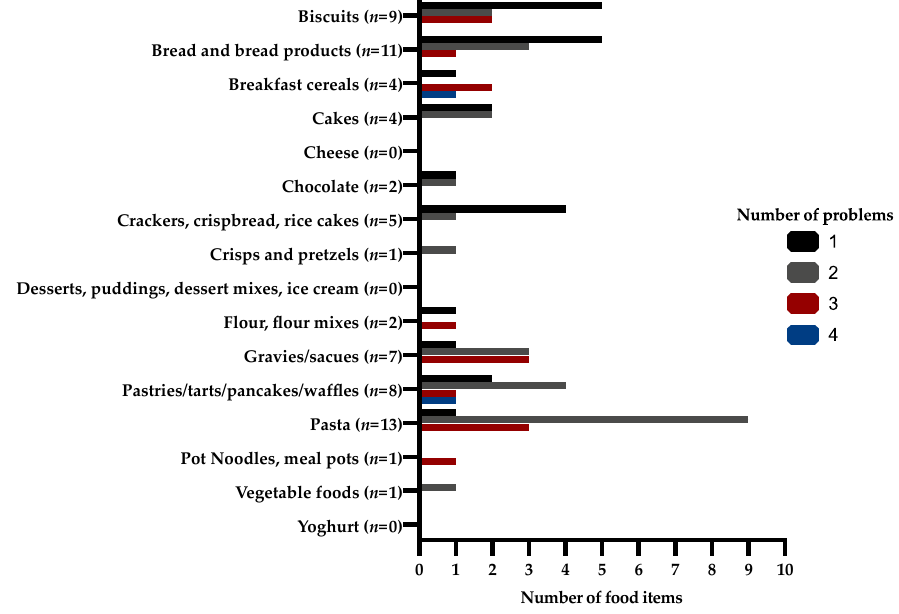
Figure 1. Frequency of misleading, omitted, or erroneous (MOE) information for “free from” food items that would affect their protein content given on the supermarket websites. Nutrients 2020 , 12 , x FOR PEER REVIEW